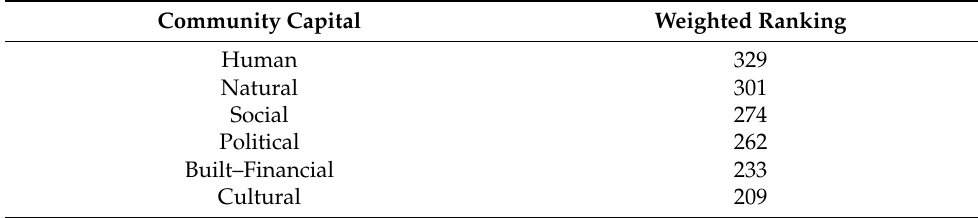
Table 4. Community Capital Weighted